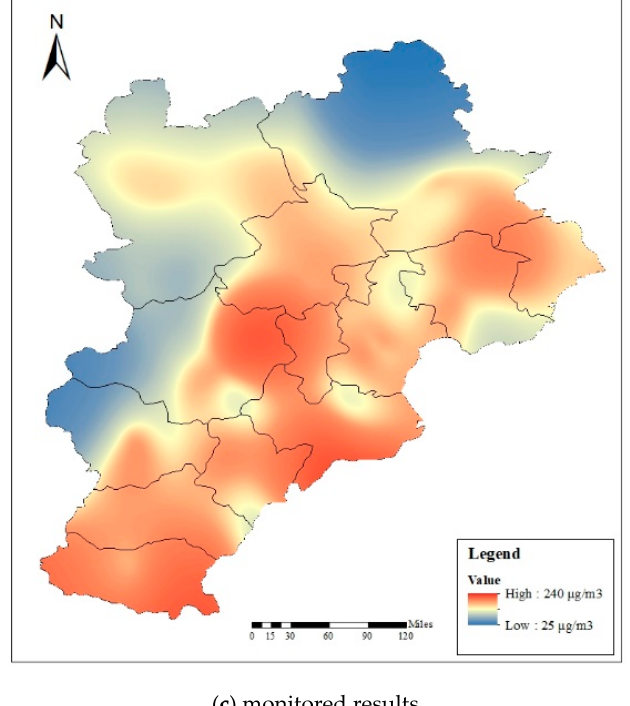
Figure 4. The spatial distributions of the PM 2.5 emission inventory, the mean simulation, and the monitored PM 2.5 concentration from the scenario 1 simulation. ( a ) PM 2.5 emission, ( b ) PM 2.5 concentration simulation results, ( c ) PM 2.5 concentration monitored results.